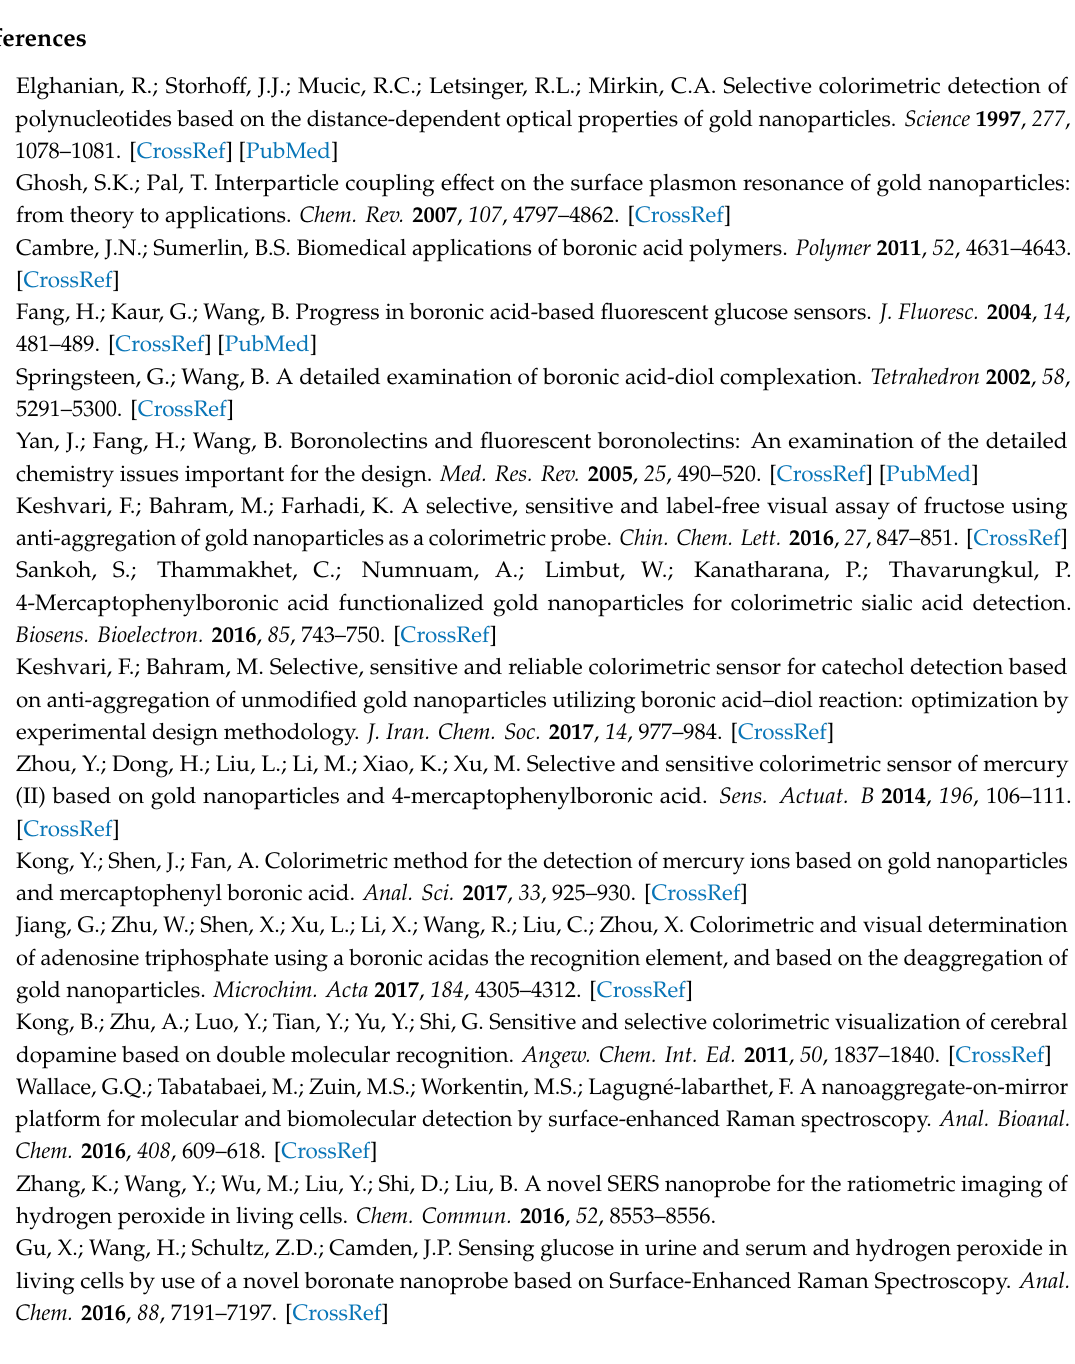
Figure S1: The change in the UV-Vis spectra of citrate-capped AuNPs modified by 4-MPBA (0.89 mM) with pH adjusted with di ff erent solutions. (A) 5 mM PBS; (B) 7.5 mM; (C) 10 mM; (D) 15 mM; (E) HCl and NaOH, Figure S2: The TEM images of citrate-capped AuNPs modified by 4-MPBA (0.16 mM) in the presence of di ff erent amount of H 2 O 2 . (1): 0; (2): 0.039%; (3): 0.058%; (4): 0.077%, Figure S3: The photo of the white precipitate formed during the reaction of 4-MPBA and H 2 O 2 (A) and the XPS spectrum of S2p3 / 2 for the white precipitate